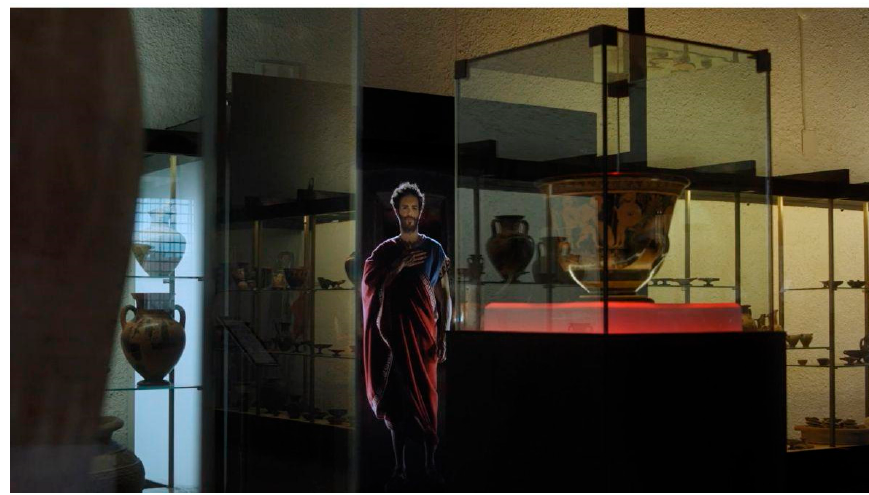
Figure 15. e-Archeo HI—Human Interface: some photos of the interactive exhibition in Cerveteri (by Blue Cinema TV).